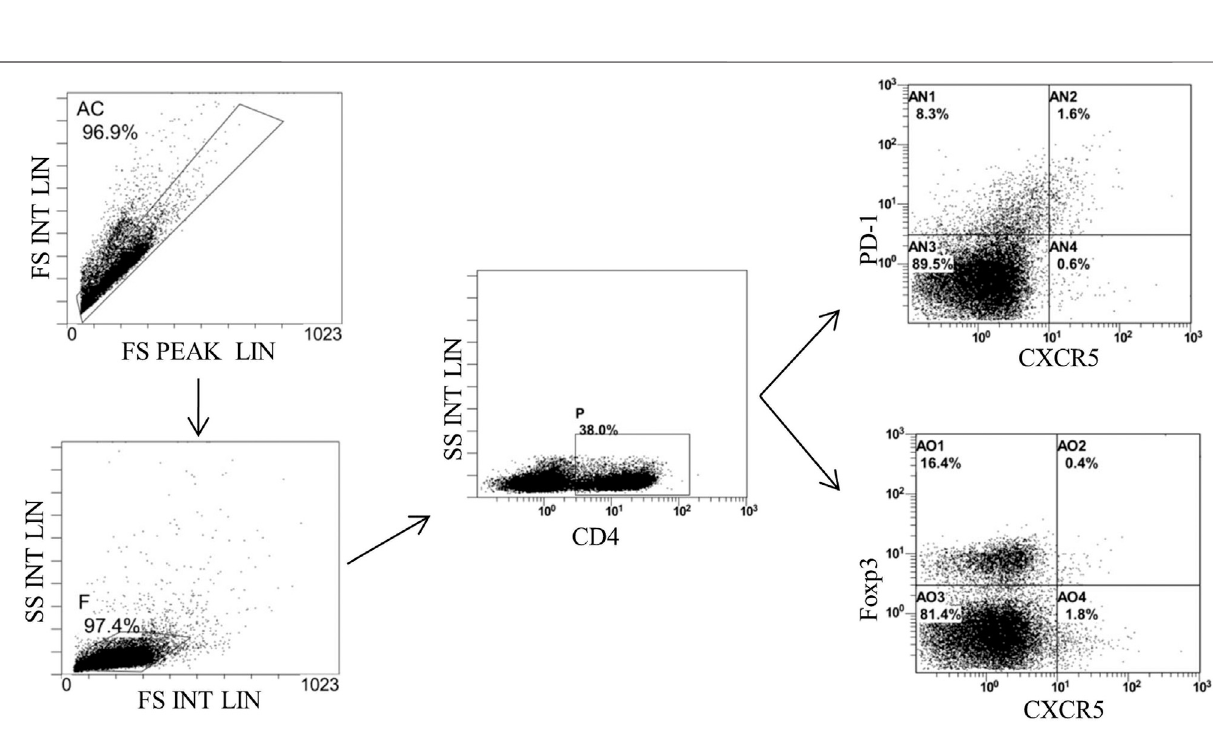
Frontiers in Pharmacology |